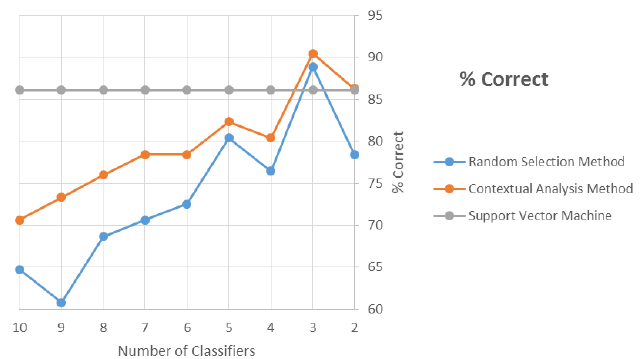
Figure 9. Evolution of the probability of correct classification for the classifier ensembles.